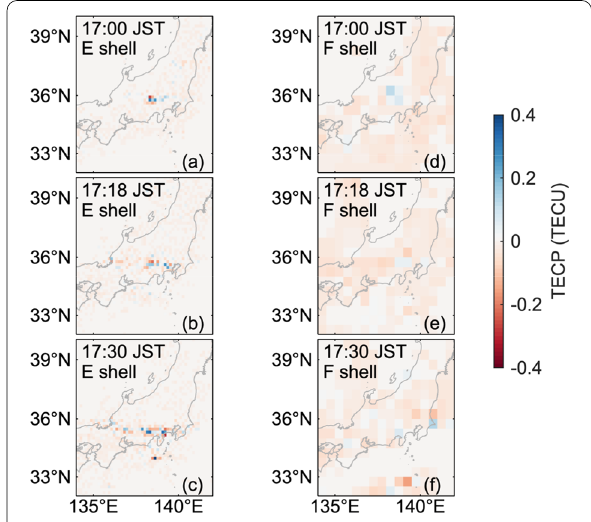
Fig. 3 Snapshots of TECP maps at E- ( a – c ) and F-shell ( d – f ) heights, at various time epochs from 17:00 to 17:30 JST (Japan Standard Time) on 21 May 2010 (day of the year (DOY)